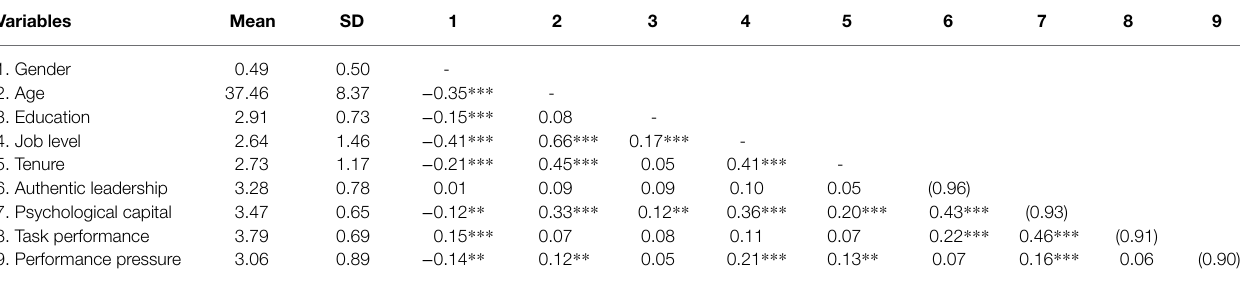
TABLE 2 | Means, standard deviations, correlations, and consistency coefficients of the variables.